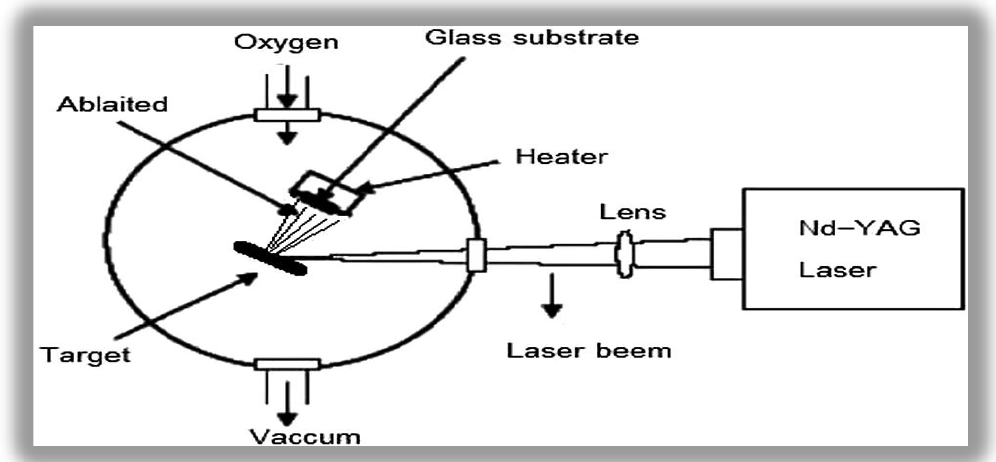
Fig. 1: Schematic diagram of pulsed laser deposition